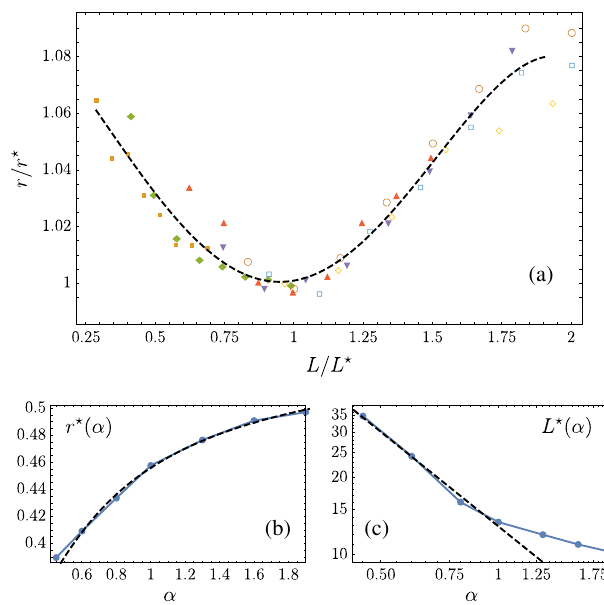
FIG. 7. (a) The average r parameter as a function of L=L (cid:4) , divided by r (cid:4) , falls onto a universal curve in the vicinity of its minimum. (b) The value of the minimum r (cid:4) ð α Þ . The dashed line is a fit of the form r (cid:4) ð α Þ ¼ r ∞ þ c 1 = α þ c 2 = α 2 , which returns r ∞ ¼ 0 . 53 (cid:2) 0 . 01 compatible with the Gaussian orthogonal ensemble value. (c) The position of the minimum L (cid:4) ð α Þ for α ¼ 1 . 9 , 1.6, 1.3, 1, 0.8, 0.6, 0.45. The dashed line is a fit of the form L (cid:4) ð α Þ ¼ c α − ν with ν ¼ 1 . 4 (cid:2) 0 . 13 for the first four